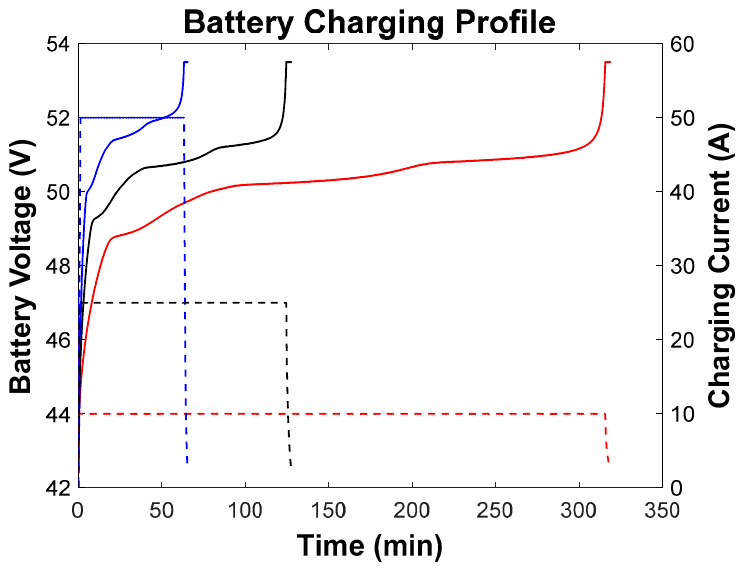
Figure 2. Experimental charging profiles at 10, 25, and 50 A for a 48NPFC50 LiFePO 4 battery.